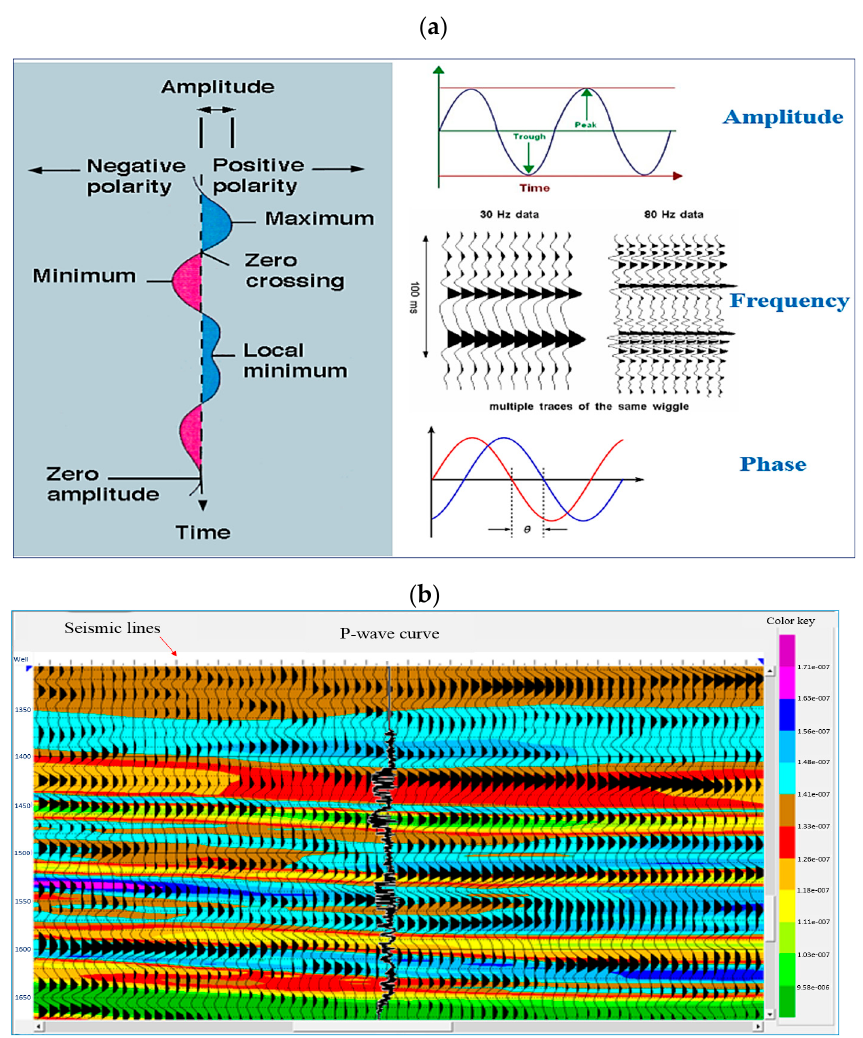
Figure 7. ( a ) The most significant components of a seismic trace; ( b ) Raw seismic data (Wiggle traces) and acoustic impedance inversion (color attribute) in the location of one of the studied wells overlain by the P-wave velocity from logging curve.